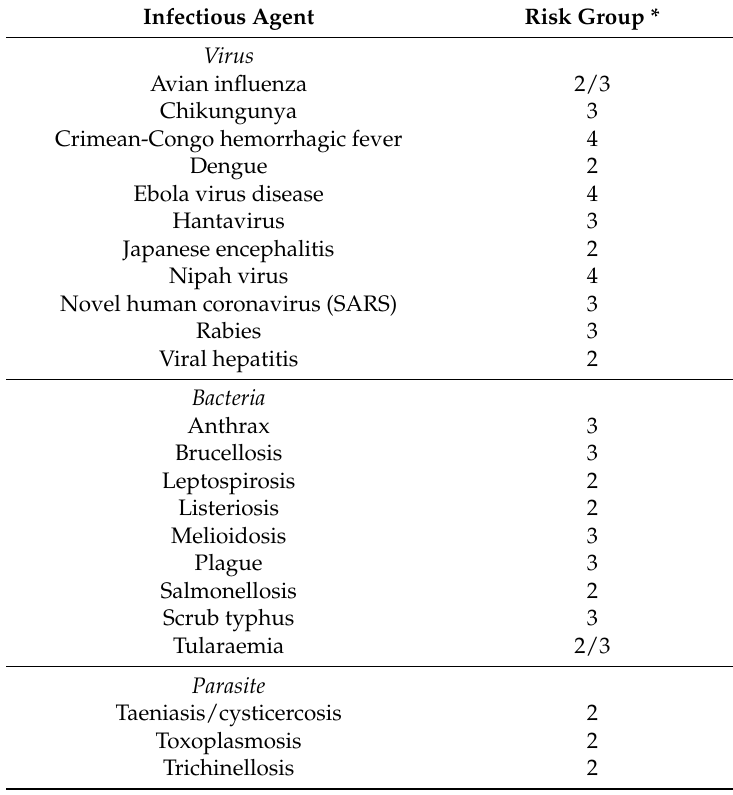
Table 2. Emerging and zoonotic infectious diseases of high risk potential in Asia-Pacific region